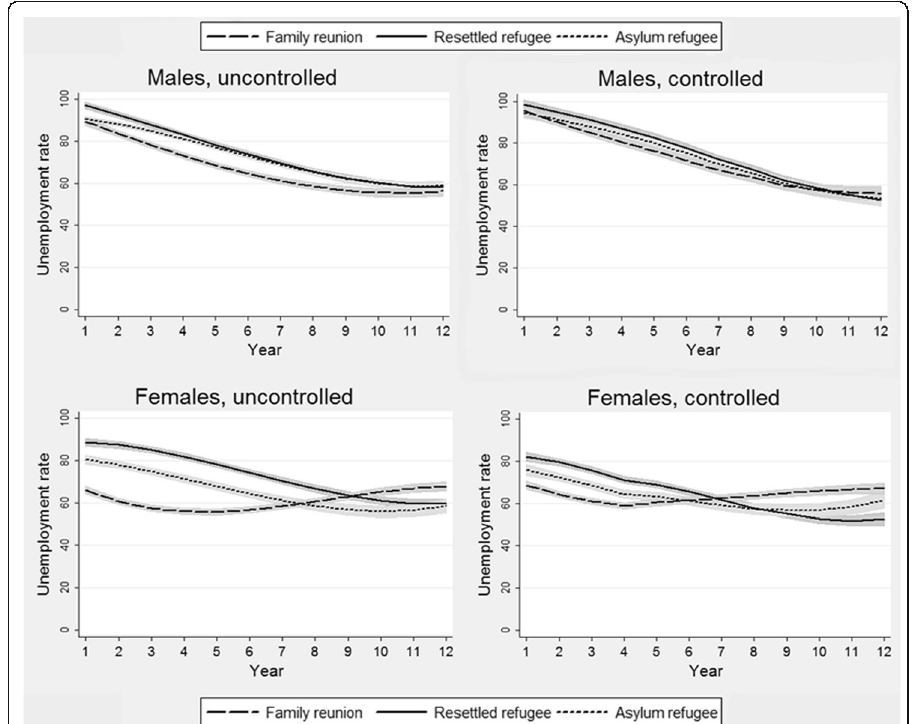
Fig. 3 The predicted unemployment rates by admission category and duration of stay among individuals aged 25 – 60. Notes: Unemployment rate is defined here as the population share of recipients of unemployment benefit during the year. Robust 95% confidence intervals are shown. Controls are held at means in particular year. See Table 3 in Appendix for regression coefficients and Figure 6 in Appendix for validation by migration